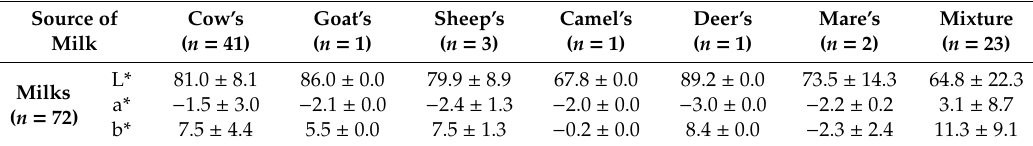
Table 8. Milk color data (mean ± st.